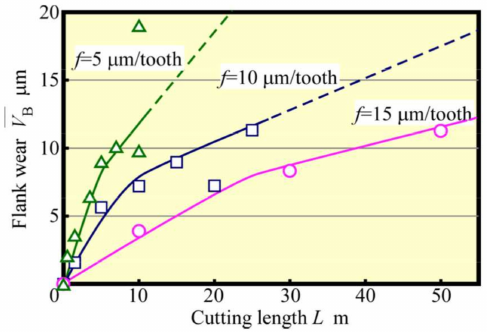
Figure 12. Relationship between flank wear and cutting length (Up cut, N s = 100,000 min − 1